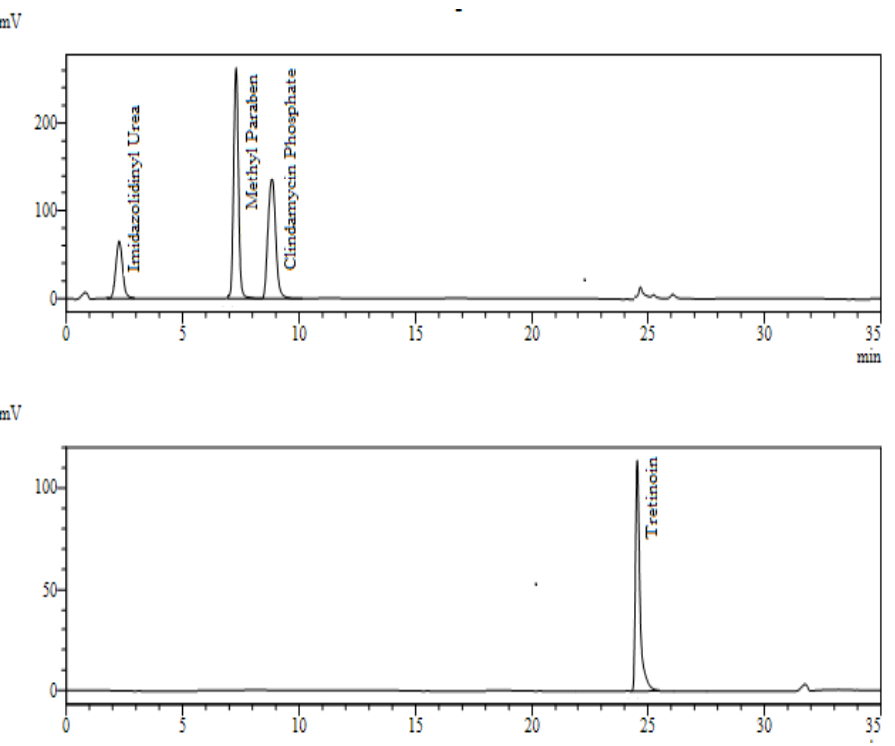
Figure 4. HPLC chromatogram of experimental gel preparation after 3 months of stress testing at 40 °C/75%RH. Peaks: imidazolidinyl urea, t R ∼ 2.2 min; methyl paraben, t R ∼ 7.3 min; clindamycin phos- phate, t R ∼ 8.9 min; iso-tretinoin, t R ∼ 20.8 min; tretinoin, t R ∼ 24.8 min.